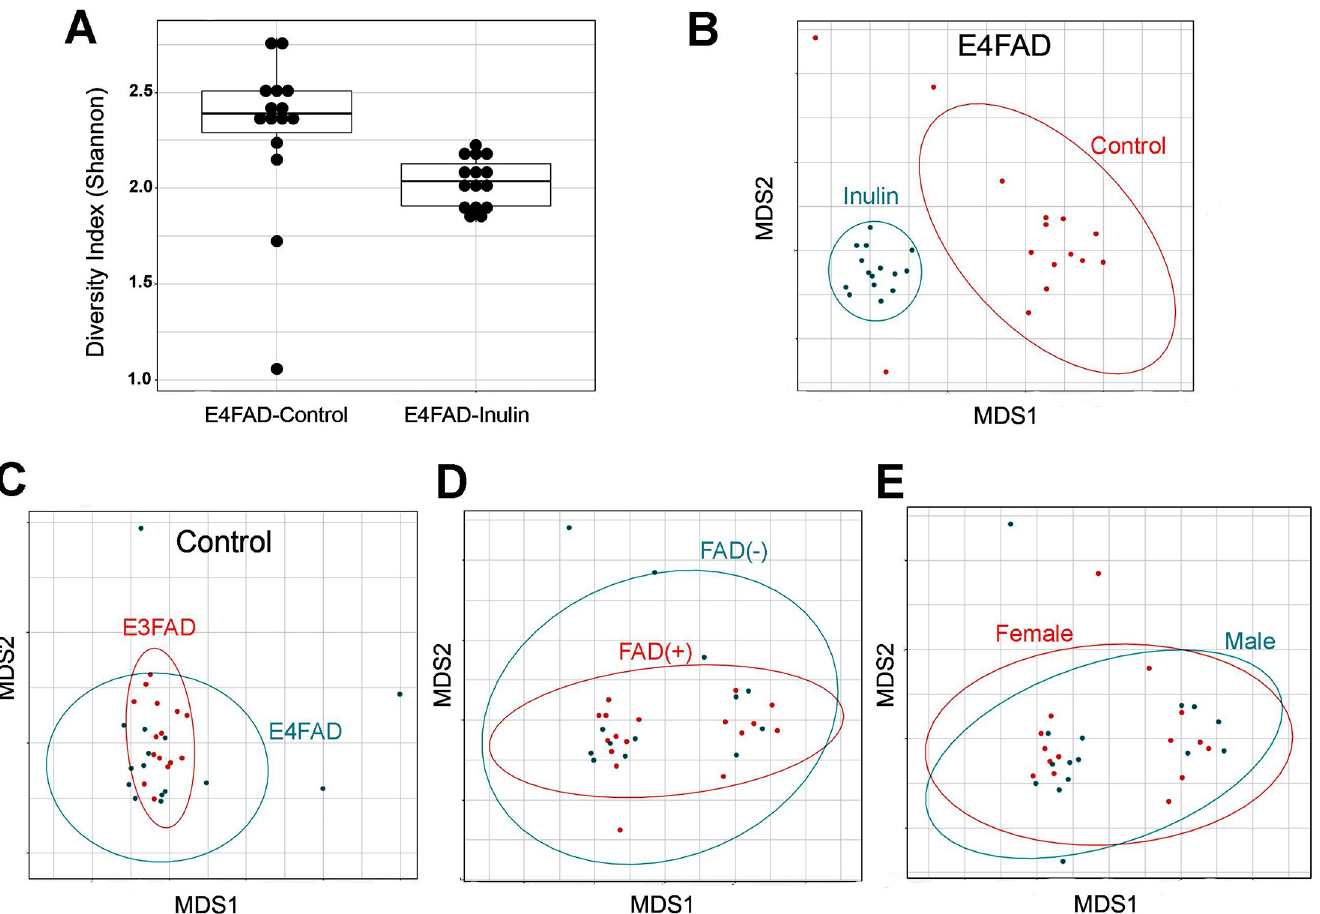
Fig 2. Analysis of inulin-induced changes in gut microbiome diversity. All analyses were performed on annotated sequence data at the genus level, rarefied to 10,000 sequences per sample. (A) E4 FAD-Inulin mice had significantly lower α -diversity (shown here as the Shannon index) than E4 FAD-Control mice ( p = 0.019). (B) E4 FAD-Control and E4 FAD-Inulin mice exhibited a significant difference in β -diversity (p = 0.001). (C) E3 FAD-Control and E4 FAD-Control mice exhibited a significant difference in β -diversity (p = 0.013). (D) Mice with and without FAD mutations (FAD (+) vs. FAD(-)) exhibited no significant difference in β -diversity (p = 0.546). (E) Male and female mice did not exhibit a significant difference in β -diversity (p =